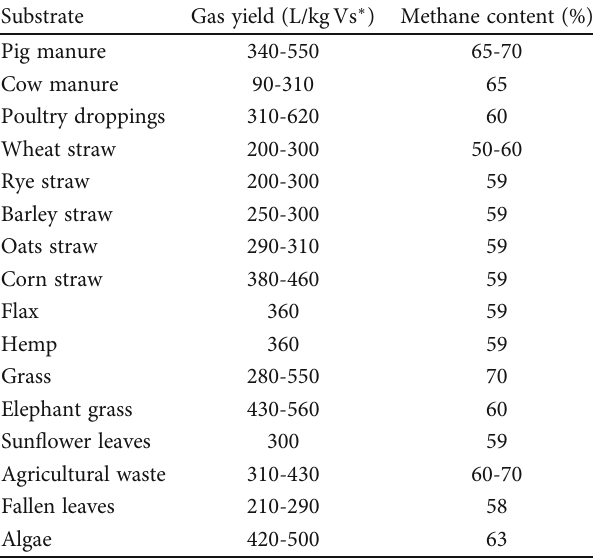
Table 3: Gas yield and methane content for di ff erent biomass [43].